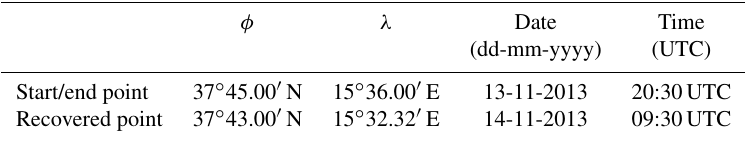
Figure 12. Particles’ cloud simulated by the model overlapped to the hydrodynamic structures. Here the leeway is calculated by means of the force balance equation. The cloud includes the target at the rescue time, and the dispersion does not seem to swamp the advection; in particular the particles’ cloud seems to separate during a longer period of time according to hydrodynamic structures ( e and f ). Table 3. Data for the second experiment: a dummy planted at a known point and rescued after 12.5h.